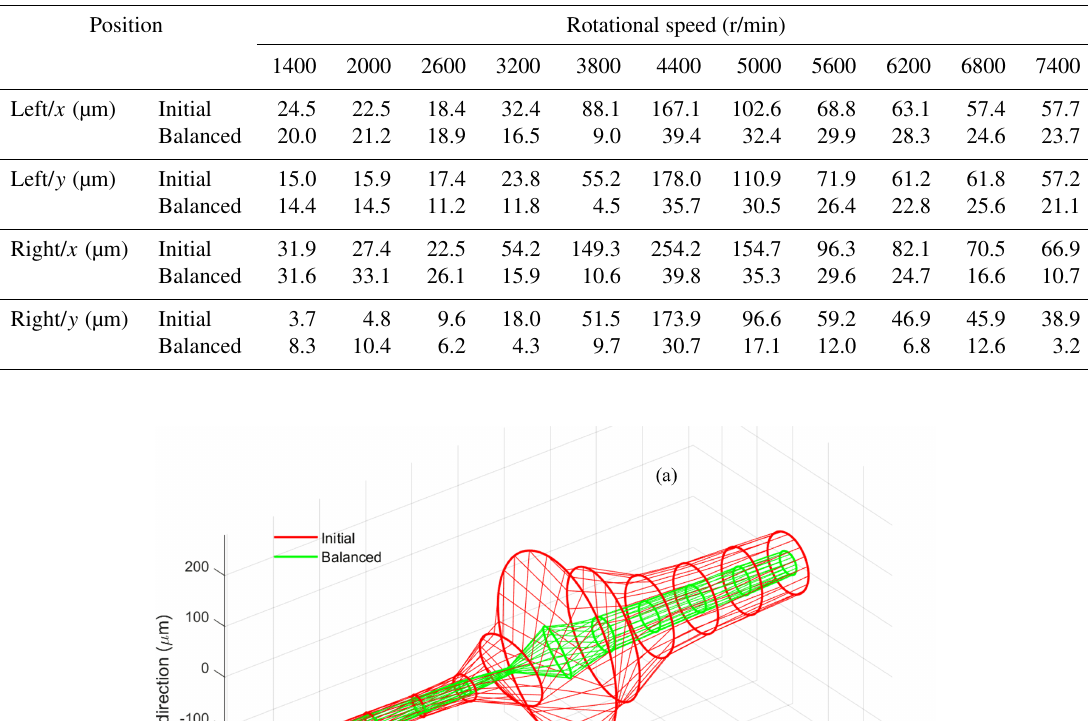
Table 3. The comparison of unbalance vibration before and after adding counterweights.